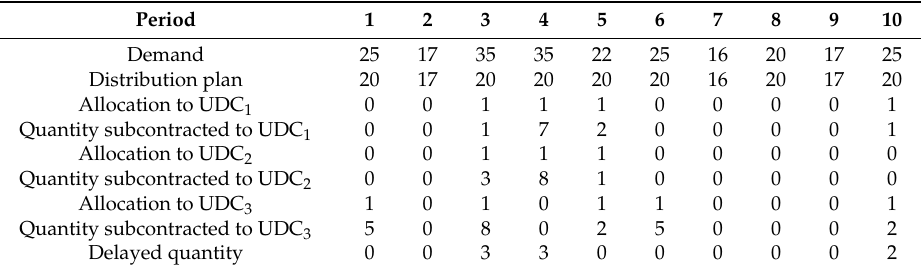
Table 7. The available capacity in each period t .